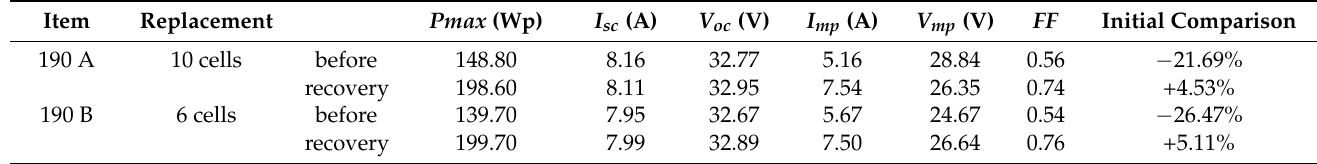
Table 6. Electrical data of modules before and after